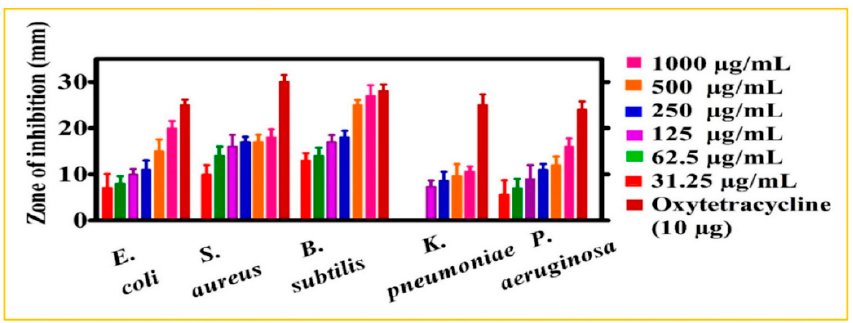
Figure 26. Growth inhibition zones for various bacterial strains exposed to green ZnO NPs of different concentrations. Oxytetracycline was used as a positive control. Reproduced from [31] under